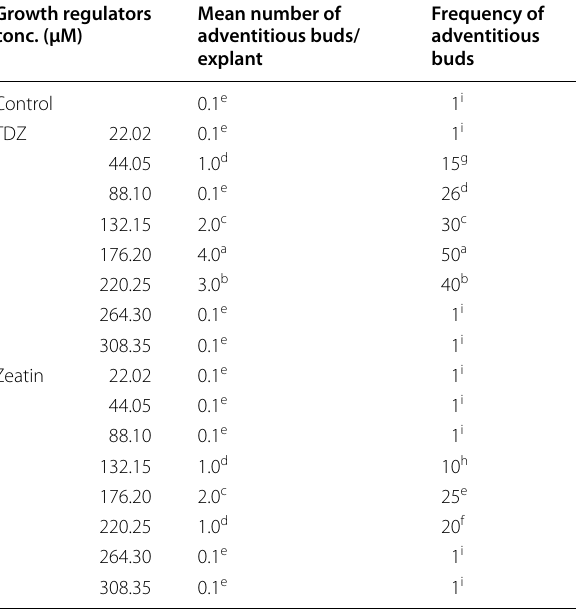
Table 3 Effects of 2,4 D and TDZ on callus formation from leaf of L. barbarum after 4 weeks of culture